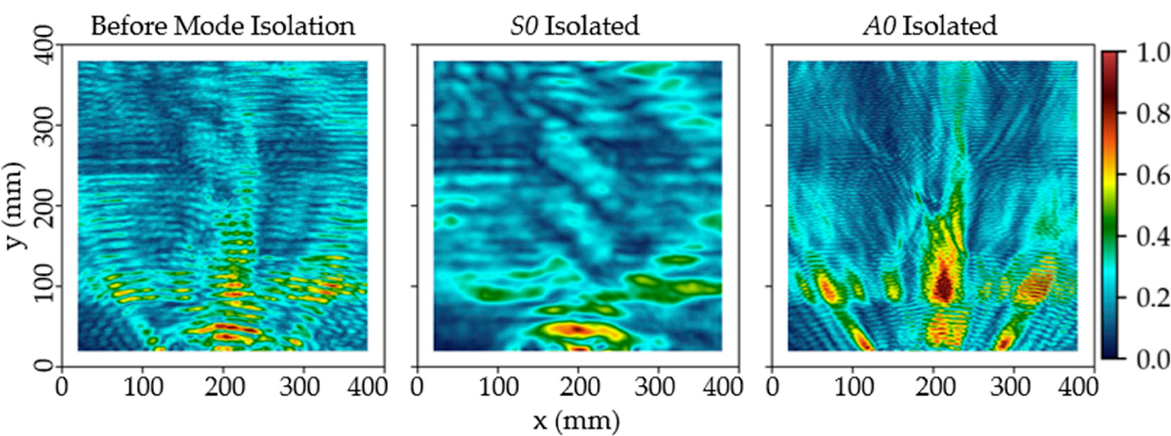
Figure 13. Spectral energy maps of Case D4, processed from unfiltered ( left ), S0 -isolated ( middle ), and A0 -isolated data ( right ). The impact damage cannot be identified due to complex waves interac- tions with the internal spar flange and stringers.